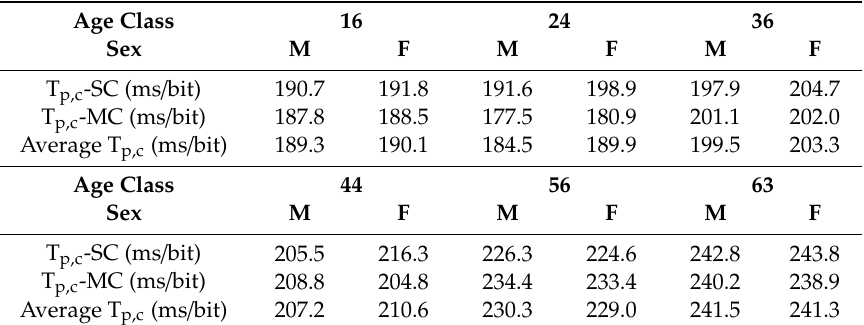
Table 2. Cognitive processing time T p,c (s, A) in single-choice (SC) and multiple-choice (MC) tests (M for male, F for female) derived from Equation (9) on the basis of data from [54].